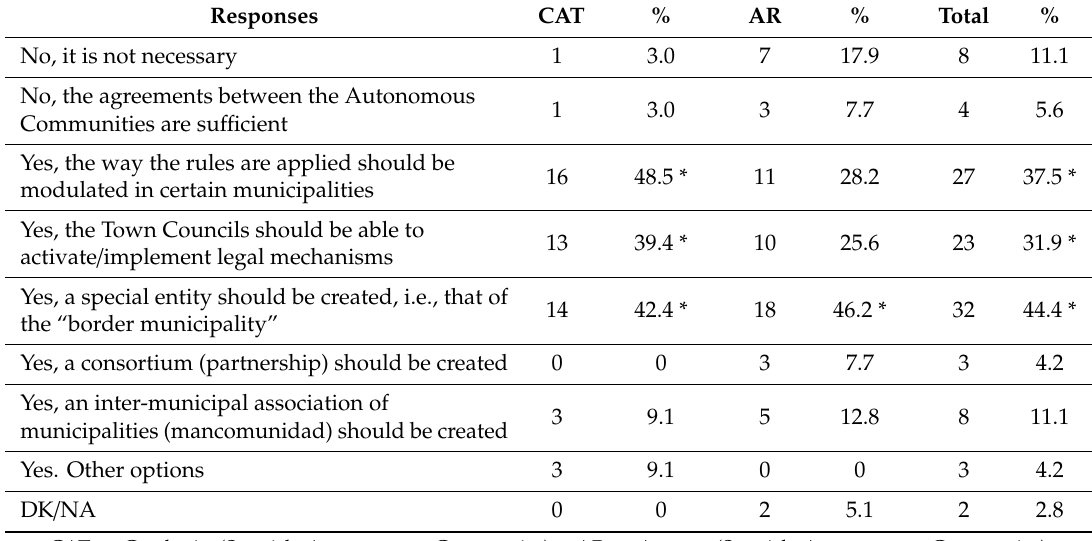
Table 8. Answers obtained in Q6 (source: